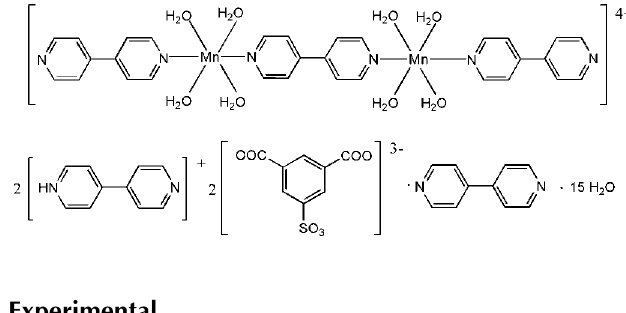
Key indicators: single-crystal X-ray study; T = 294 K; mean (cid:2) (C–C) = 0.005 A˚; R factor = 0.053; wR factor = 0.157; data-to-parameter ratio = 15.0.